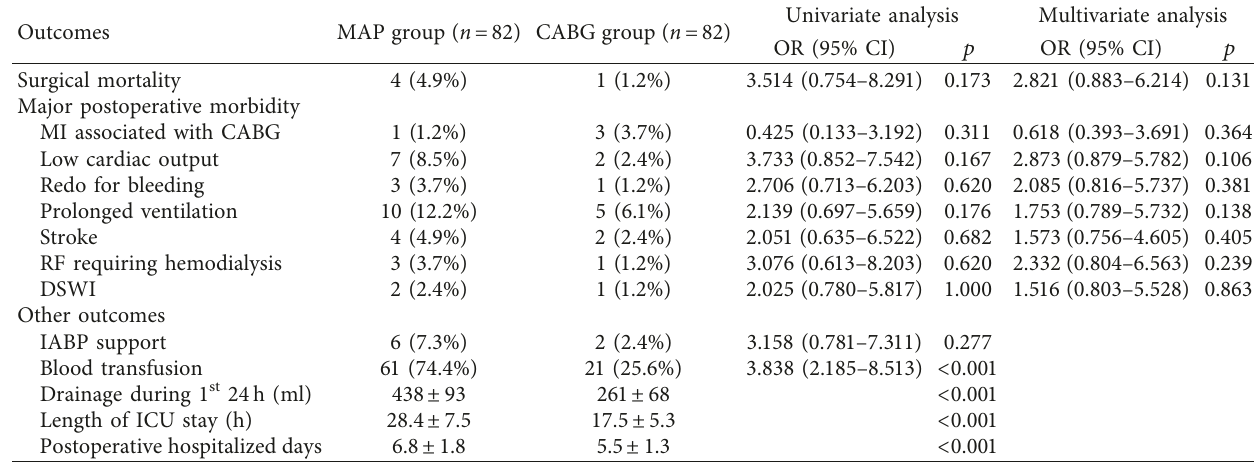
Table 2: In-hospital outcomes in the matched population.